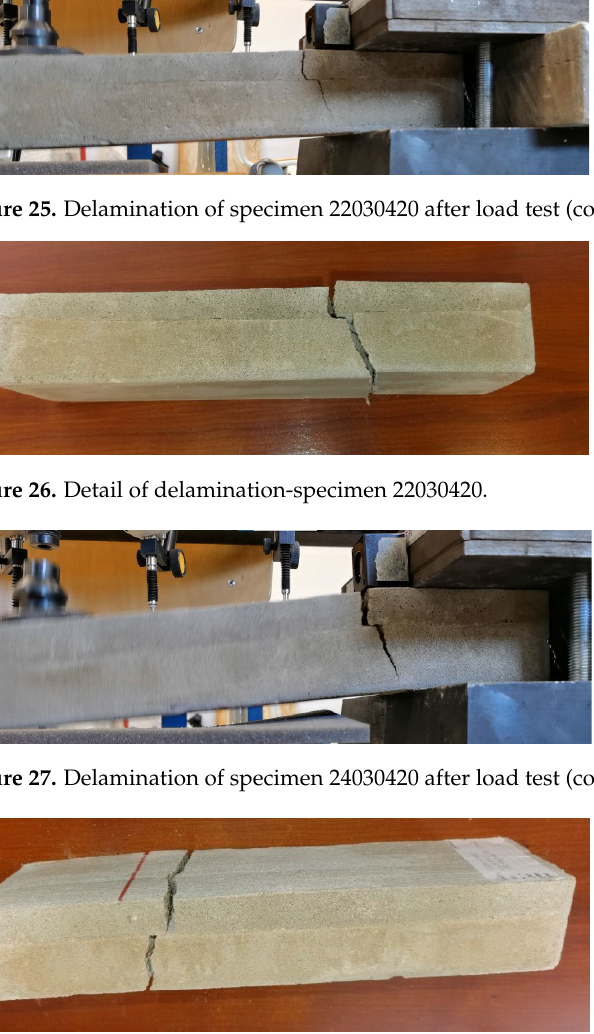
Figure 28. Detail of delamination- specimen 24030420.